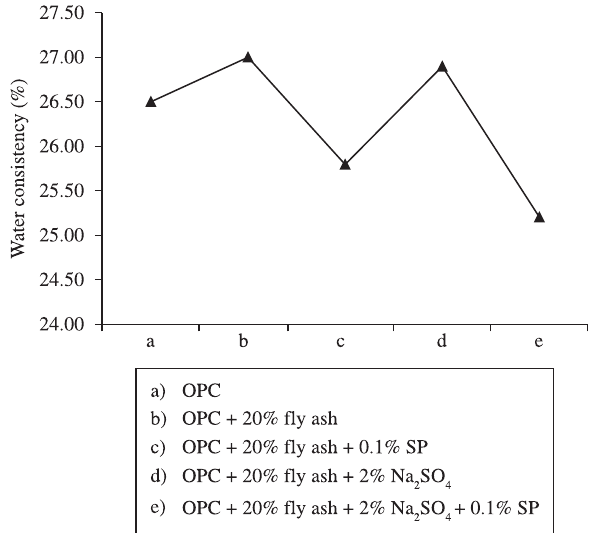
Figure 3. Variation of setting times.